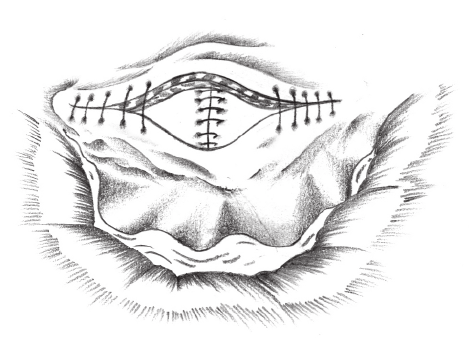
Figure 5 - Suture of the urethra and suture of the anterior wall of the rectum.